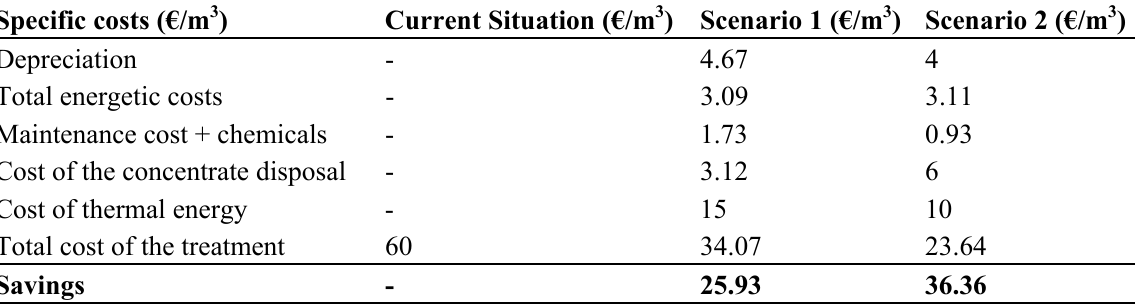
Table 4. Specific costs for the proposed